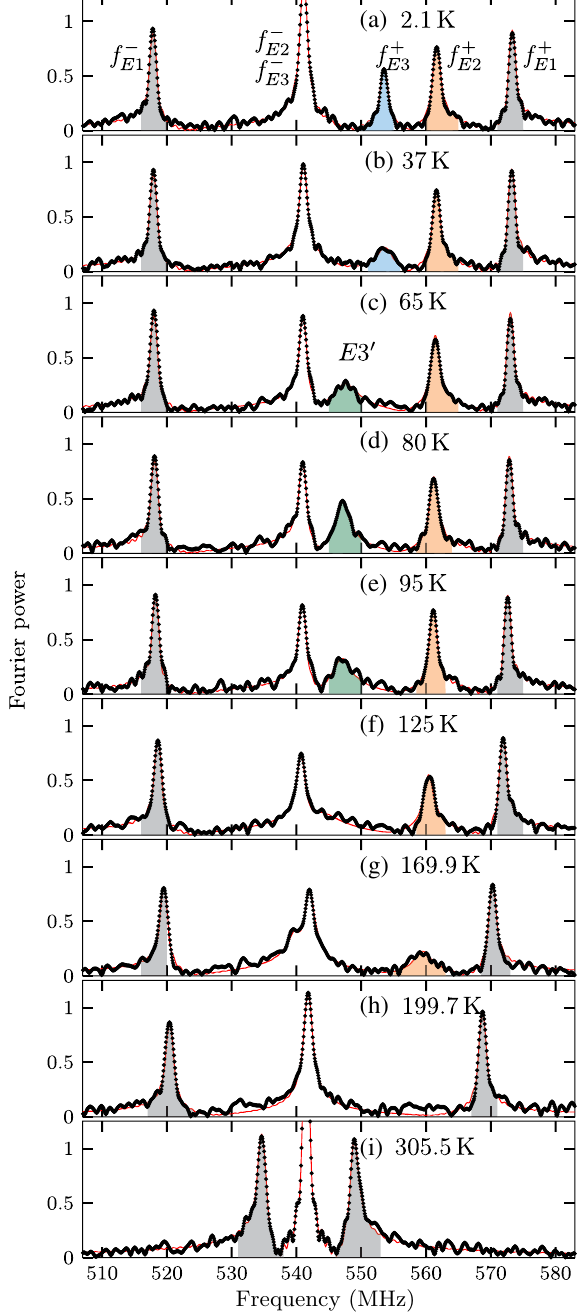
FIG. 5. (a) – (g) Temperature dependence of FTs of μ SR spectra ¼ 4 T jj c . taken in B ext